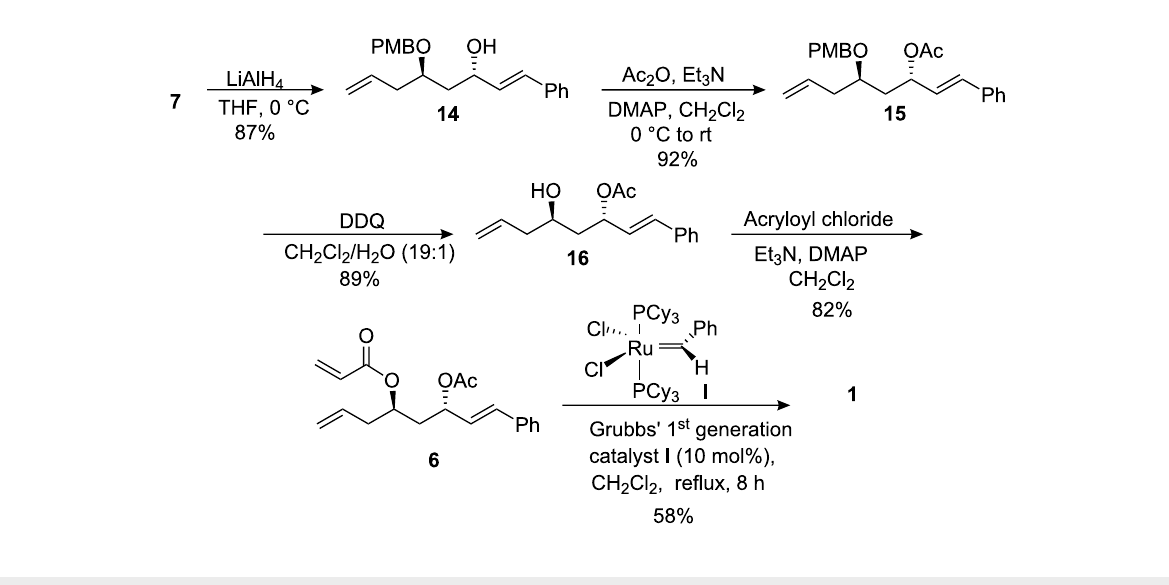
Scheme 3: Synthesis of cryptocaryalactone by